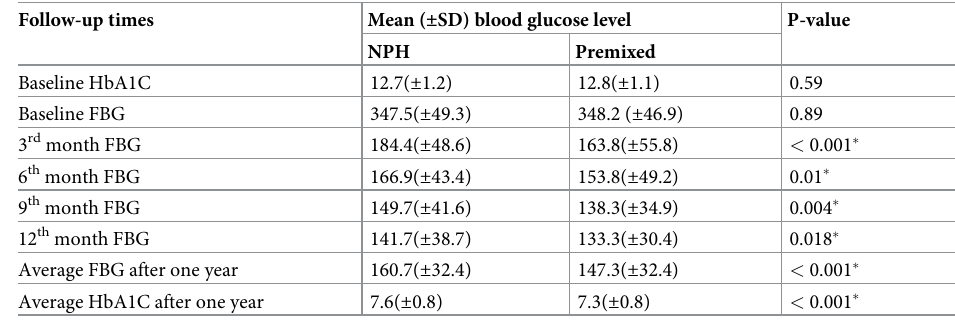
Table 3. Comparison of blood glucose levels between NPH and premixed insulin